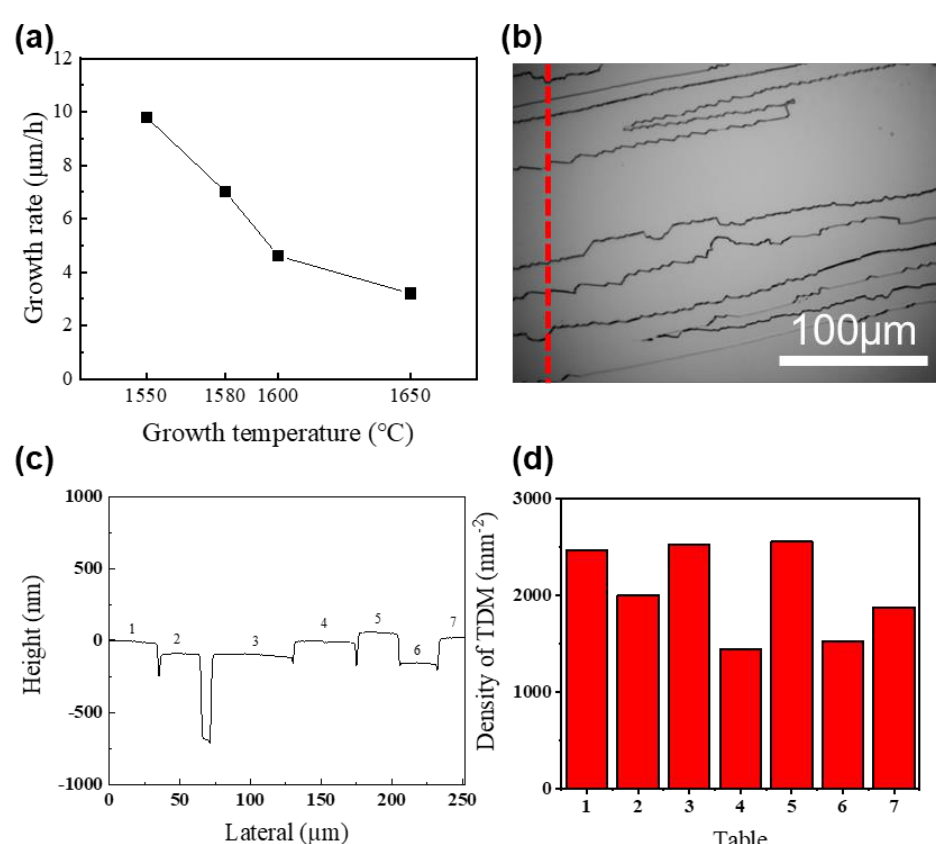
Figure 6. ( a ) Growth rate of samples at different T g . ( b ) Region investigated on the sample of T g = 1650 °C. ( c ) The relative heights of the seven consecutive LMRs. ( d ) The density of TPs on different tables.